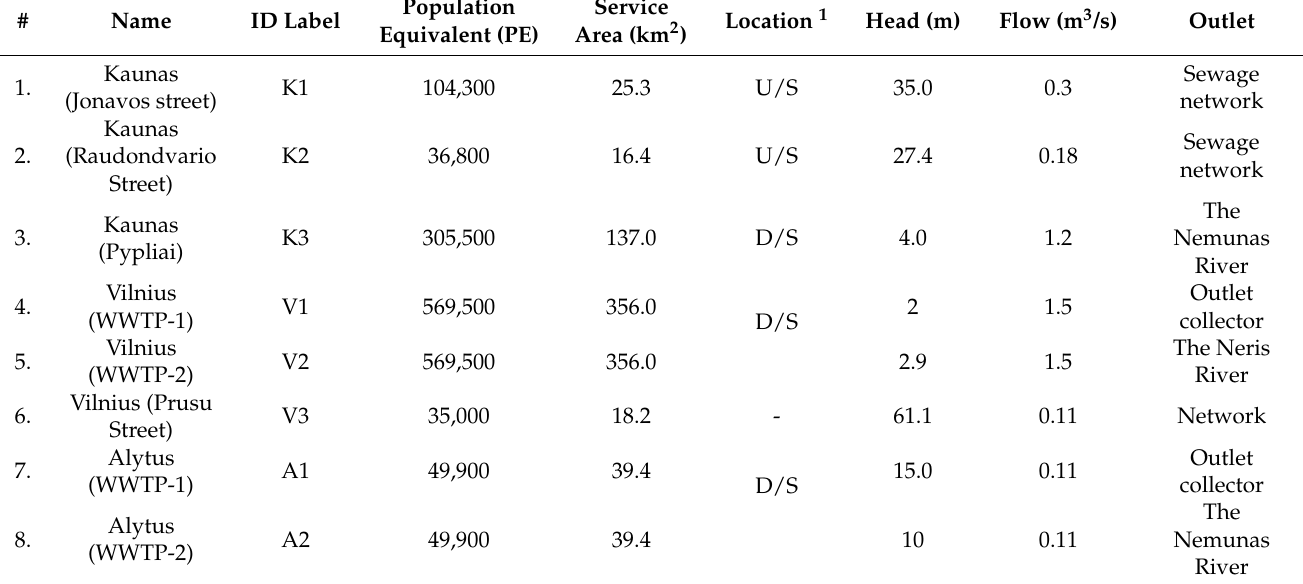
Table 2. Potential sites for installing hydropower turbines in urban water networks of Vilnius, Kaunas, and Alytus.